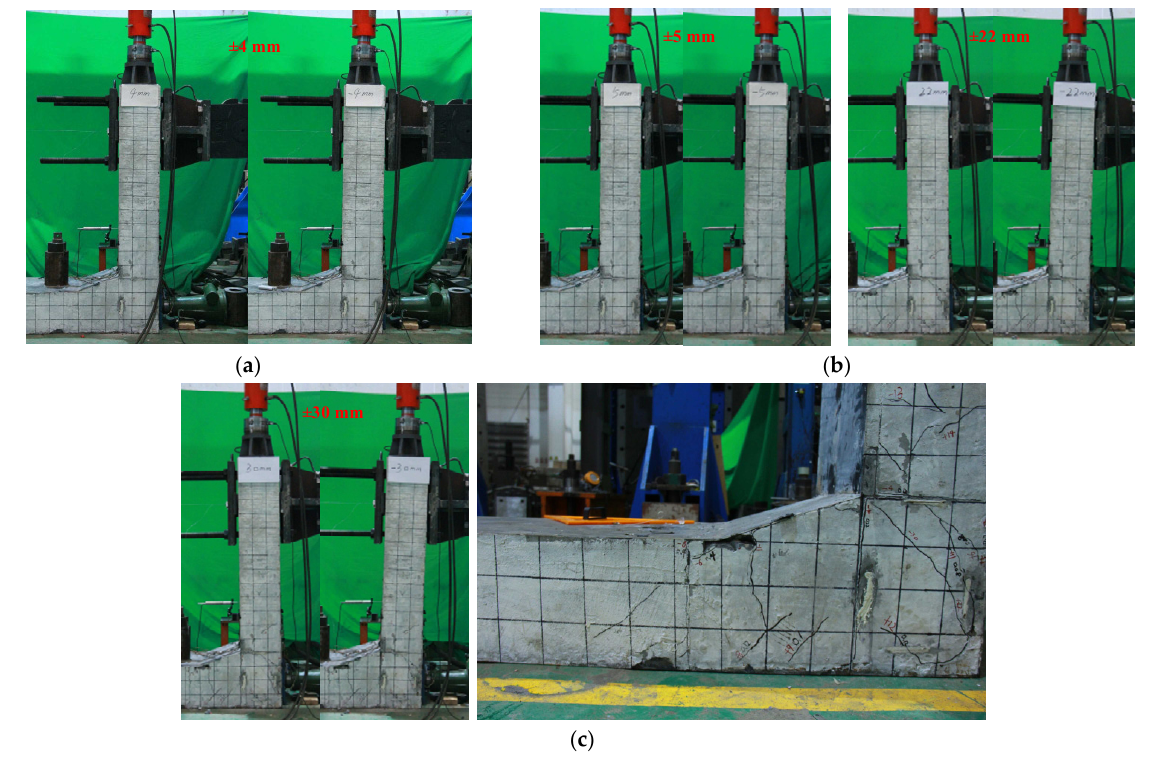
Figure 9. Test phenomena of L-shaped specimens. ( a ) Uncracked stage (4 mm); ( b ) cracking stage (5 to 22 mm); ( c ) damage phase (30 mm).